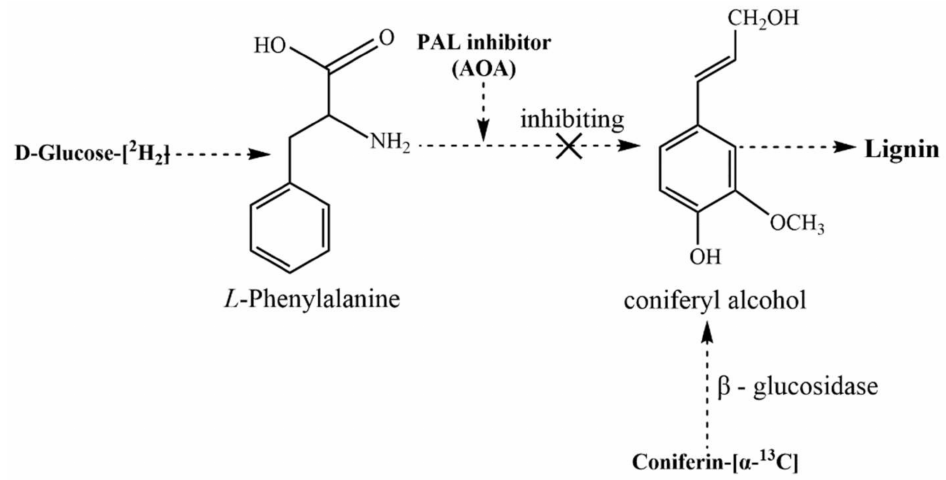
Figure 13. Inhibiting of D-glucose-[6- 2 H 2 ] transformation to lignin and metabolism of coniferin-[ α - 13 C].